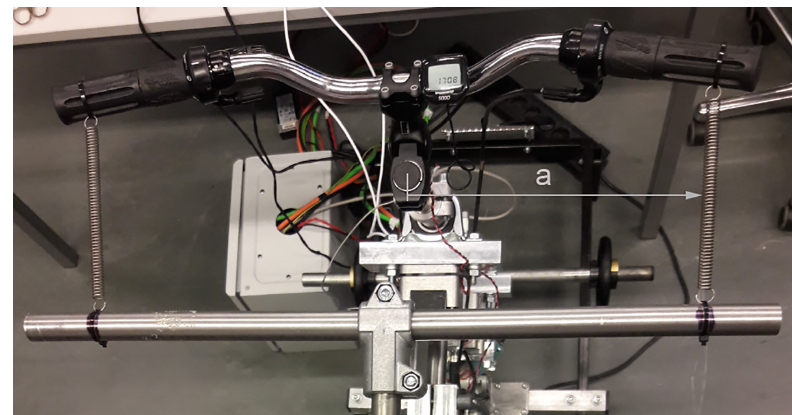
Figure 11. Experimental set-up to measure moment of inertia.